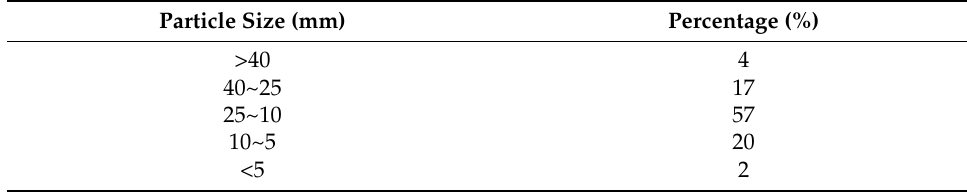
Table 1. The particle size proportion of sinter.